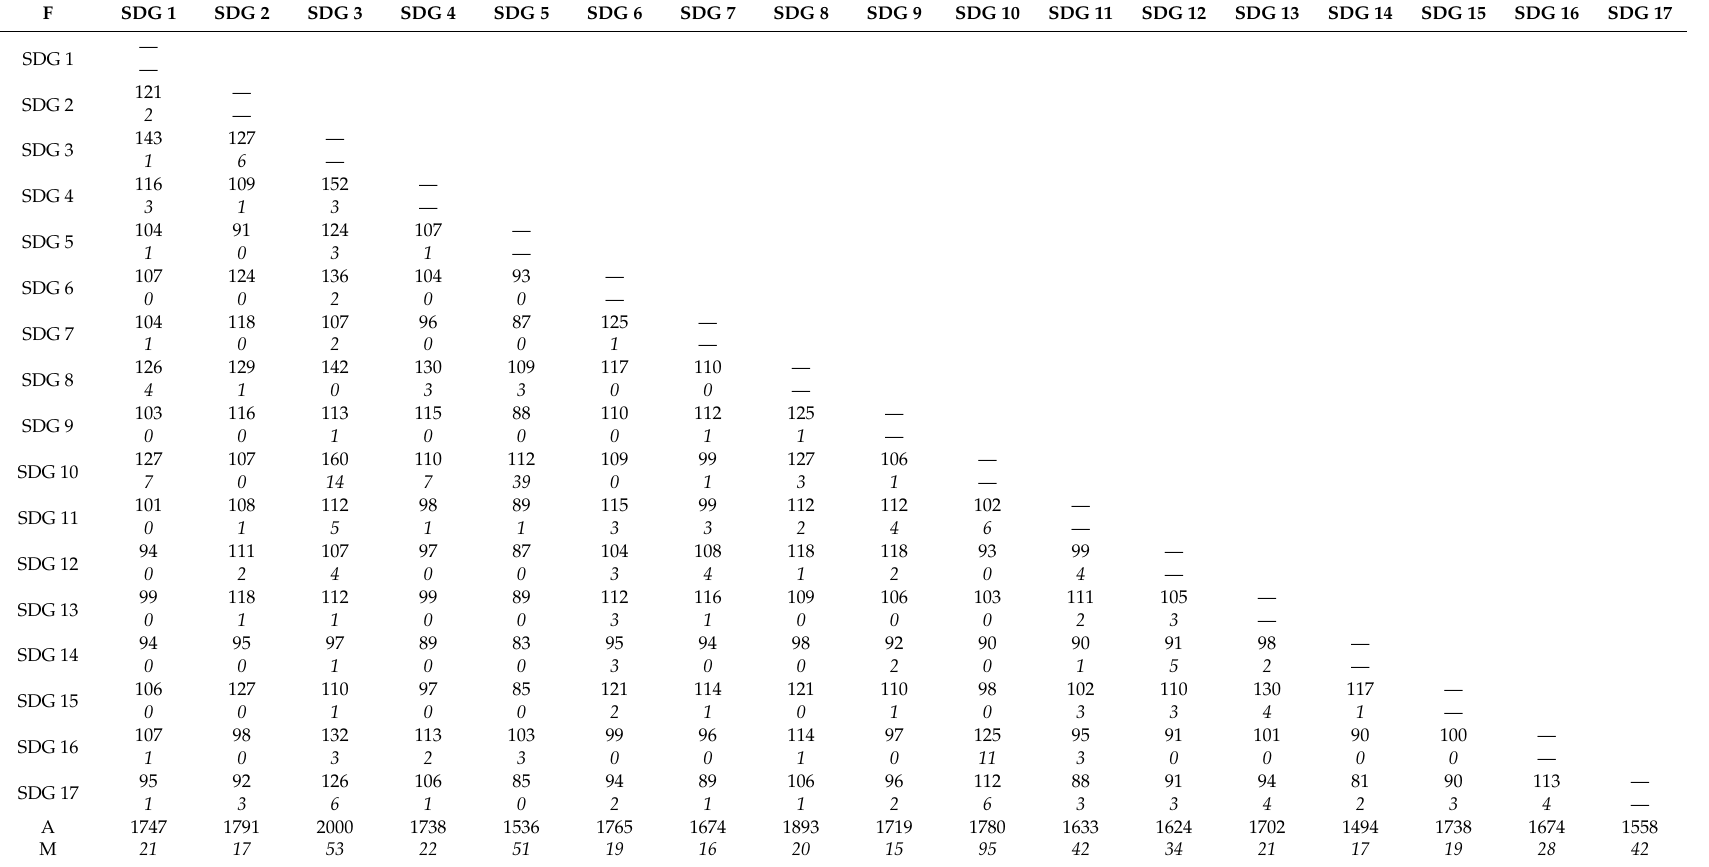
Table 2. The crosstabulation of SDG-paired works in academia and